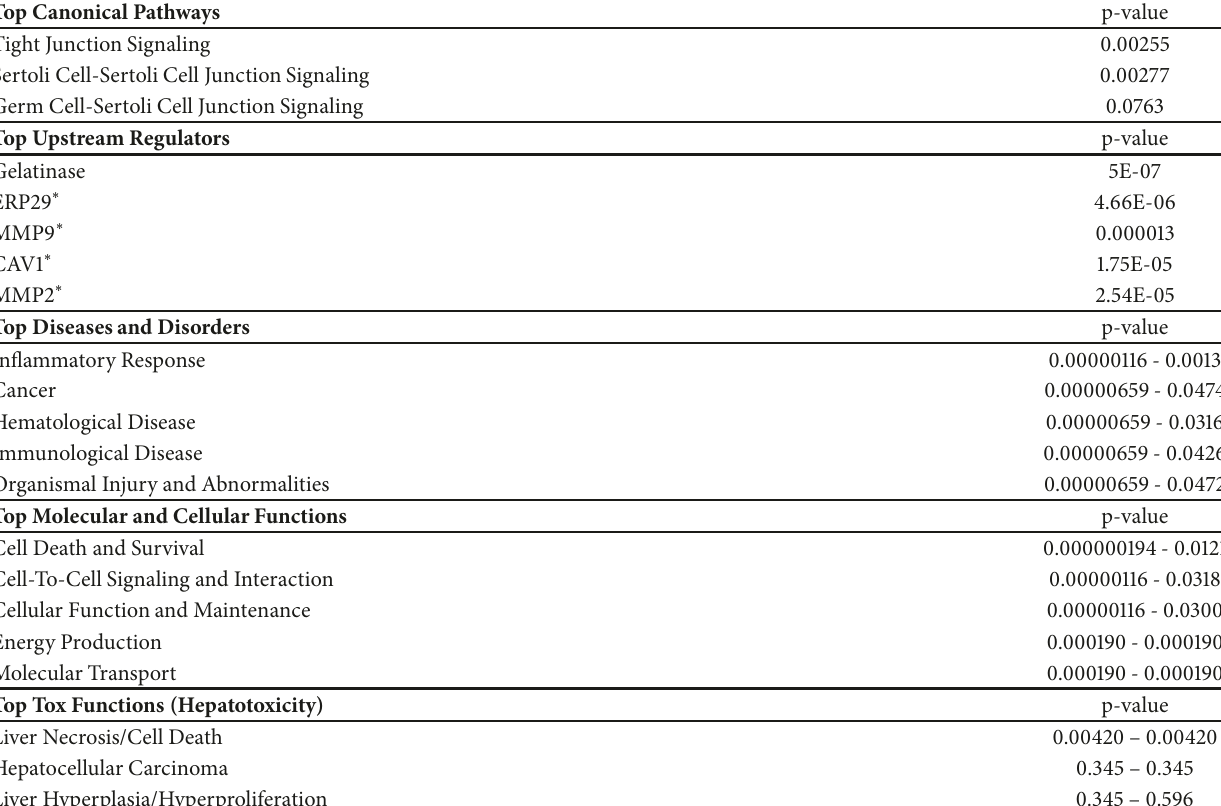
Table 3: Top canonical pathways, top diseases and biological functions, and top toxicology functions revealed by the eleven common miR targets of the MetS-FL trio, ZO-1, and Occludin.